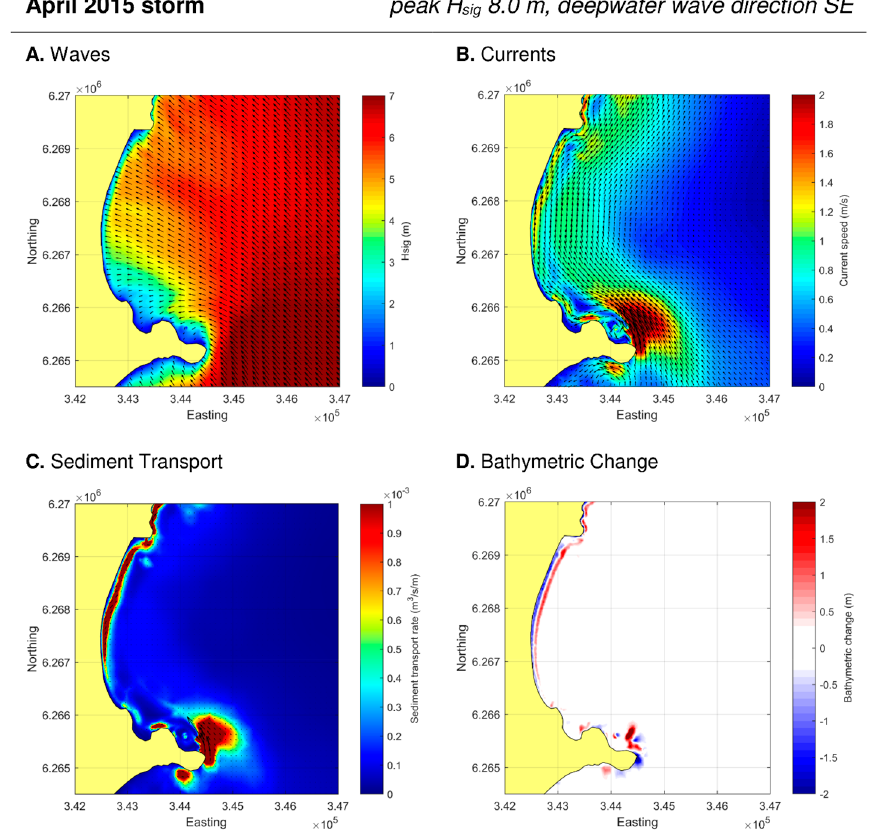
Figure 9. Modelling results for ( A ) significant wave height and mean wave direction; ( B ) current velocity and direction ( C ) sediment transport rate and direction; and ( D ) bathymetric change at Narrabeen–Collaroy during the April 2015 storm event. Results shown in ( A – C ) are at the storm peak; while ( D ) is the cumulative change post ‐ event. Bathymetric change in ( D ) less than ±0.03 m was omitted, consistent with limits of model calibration (Section 3).